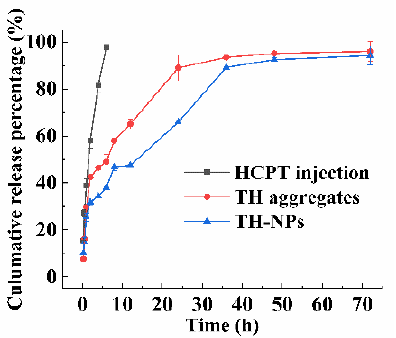
Figure 6. The cumulative in vitro drug release of HCPT injection, TH aggregates and TH-NPs in PBS (pH 7.4) ( n = 3, mean ± SD).